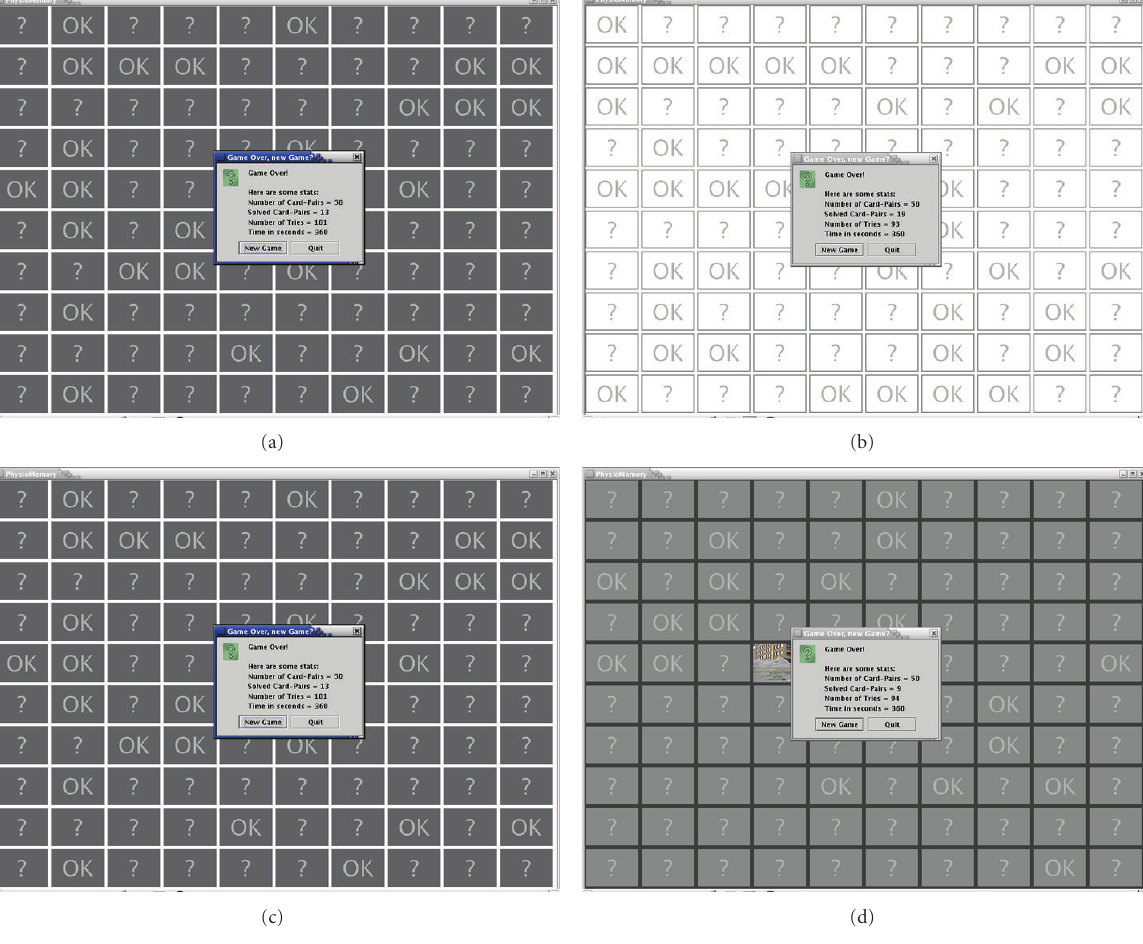
Figure 6: Final appearances of evolved user